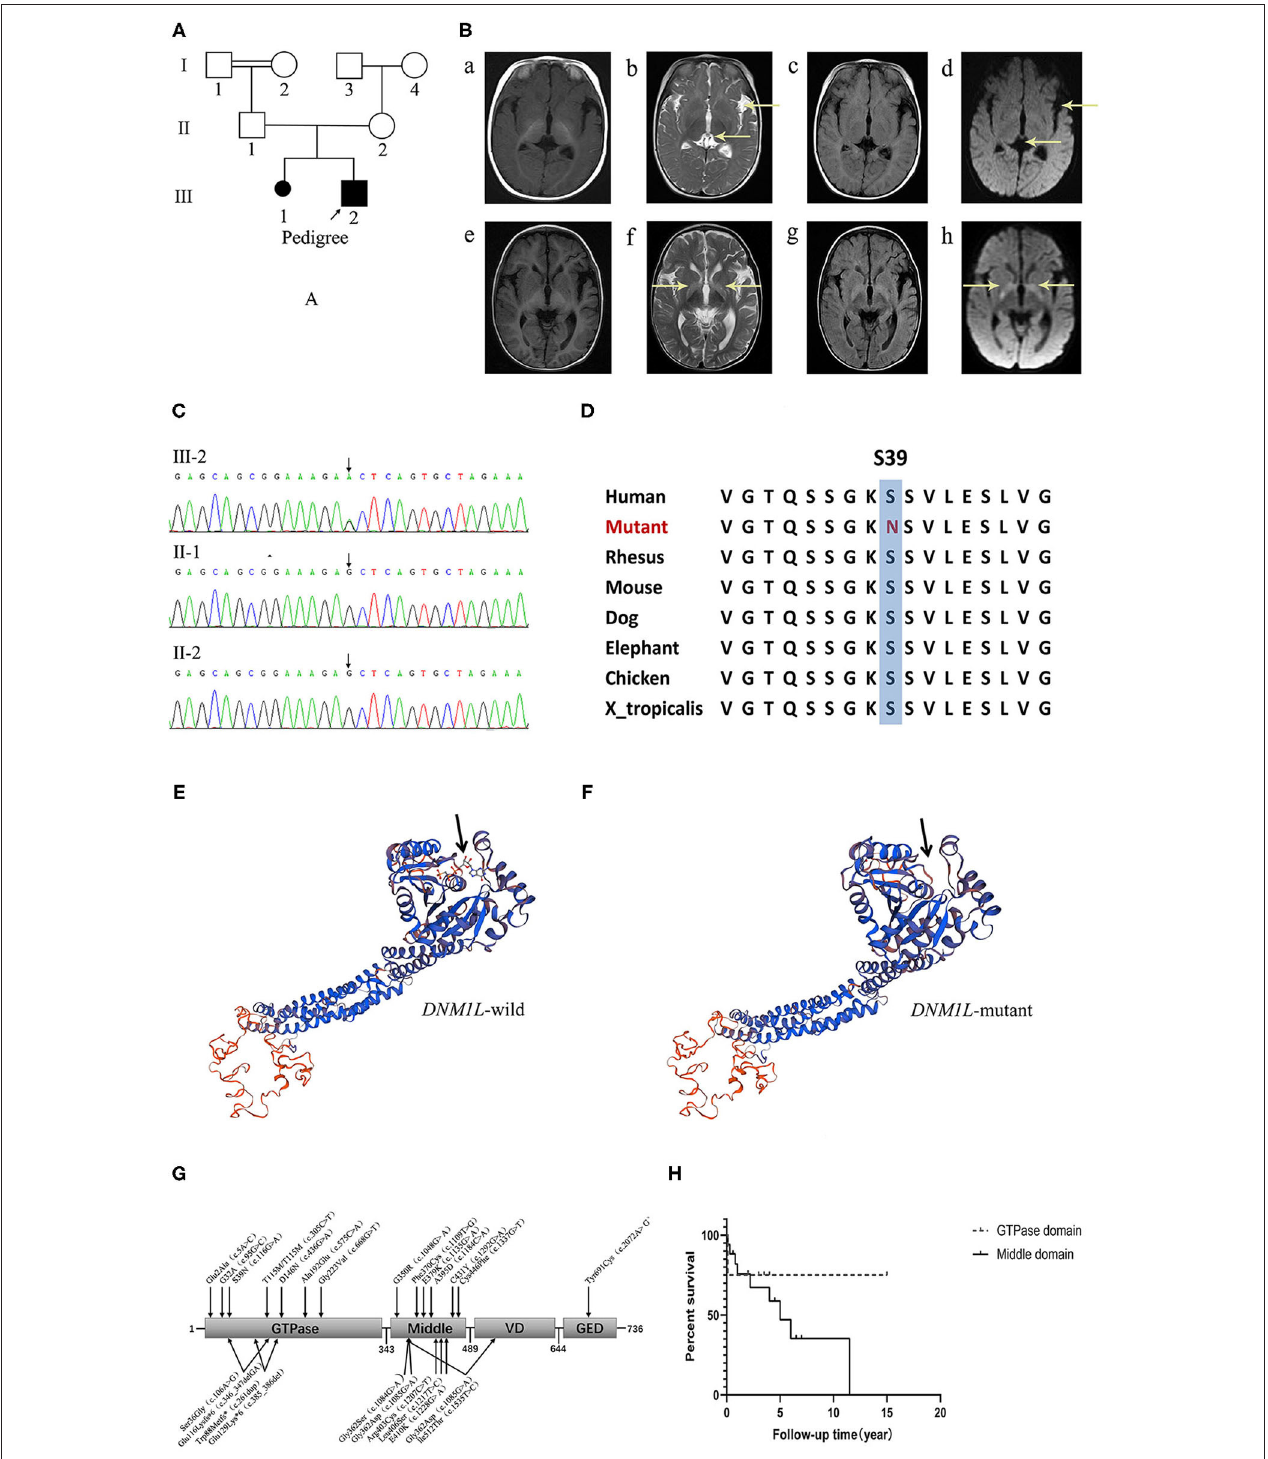
FIGURE 1 | (A) The pedigree of the family. (B) Brain MR images at 5-, and 18-months of age. (a–d) show that the ventricles of the brain and the left lateral fissure were widened on T1WI, T2WI, FLAIR and DWI sequences at 5-months of age. (e–h) disclose symmetrical hyperintensity in the bilateral basal ganglia on T2WI, FLAIR, and DWI sequences at 18-months of age. (C) Electropherograms of the regions containing the DNM1L variant identified in genomic DNA from the patient. (D) The conservation of the identified amino acid across different species. (E,F) The protein 3D modeling for the DNM1L -wild and identified missense variant. (G) The schematic chart and the locations of identified variants in DRP1. (H) The survival curve of patients of the GTPase domain group and the middle domain group of DRP1.